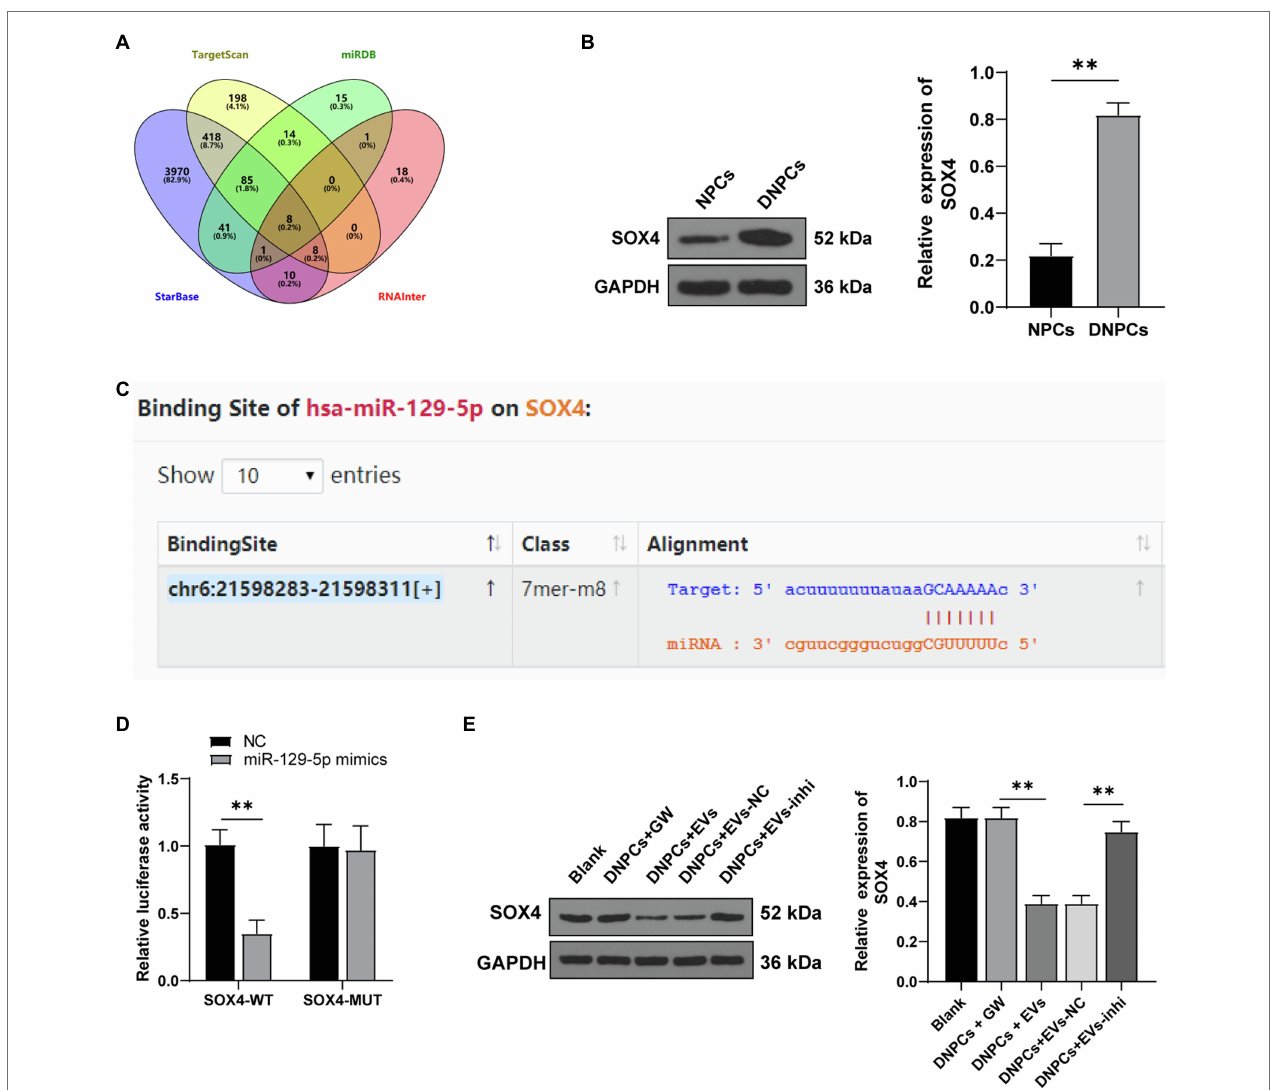
FIGURE 5 | miR-129-5p targeted SRY-box transcription factor 4 (SOX4). (A) Eight downstream target genes of miR-129-5p screened through the StarBase, TargetScan, RNAInter, and miRDB databases; (B) SOX4 expression in NPCs and DNPCs detected by Western blot; (C) binding sites of miR-129-5p and SOX4 predicted on the StarBase database; (D) target relationship between miR-129-5p and SOX4 verified by dual-luciferase assay; (E) SOX4 expression in DNPCs detected by Western blot. Cell experiment was repeated three times. Data were presented as mean ± standard error. Data in panels (B,D) were analyzed using independent t test, while data in panel (E) were analyzed using one-way ANOVA, followed by Tukey’s multiple comparisons test. ** p <